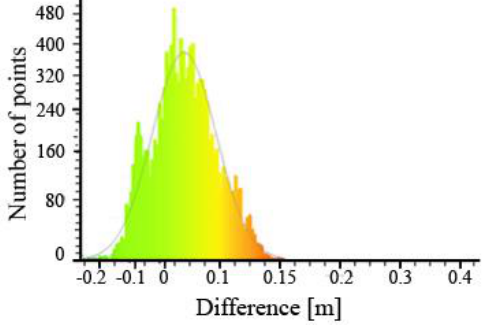
Figure 23. A graph showing a distribution of the cloud deviations of Test Area No. 4.